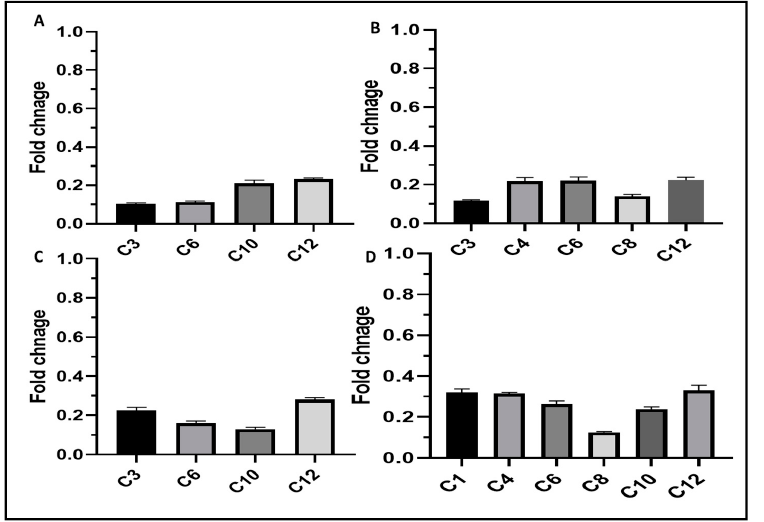
Figure 11. Bar charts showing the downregulation caused by AgNPs in the expression of ( A ) BCR 1, ( B ) PLB 2, ( C ) ALS 1, and ( D ) SAP 5 genes in C. albicans isolates.